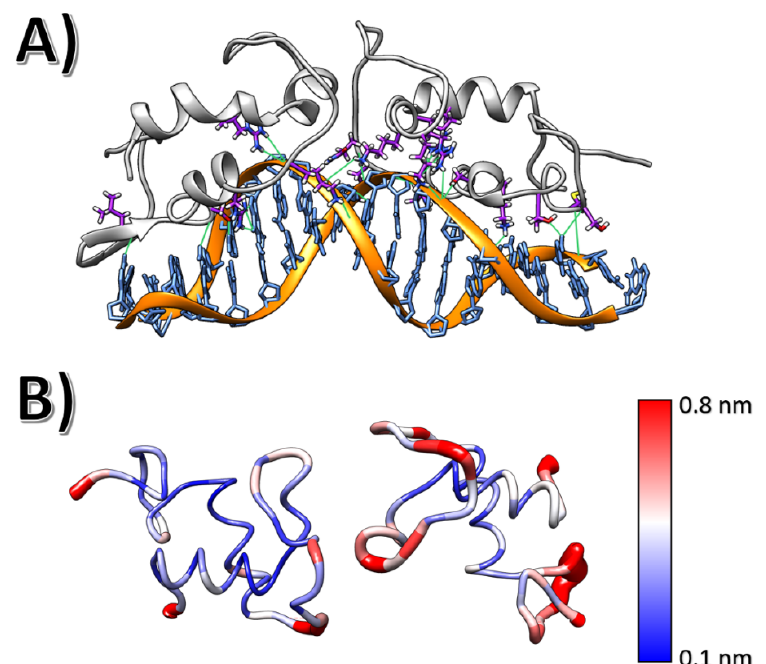
Figure 2. ( A ) AR-DBD-ARE average conformation acquired during a 300 ns MD simulation. AR-DBD residues were found to interact with the ARE element; hydrogen bonds are depicted in green. ( B ) Root mean square fluctuation per residue for both AR-DBD monomers, with the respective colour scale.